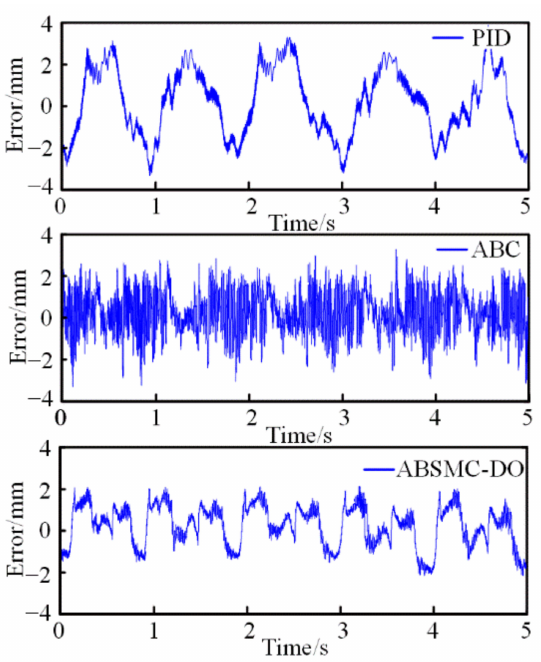
Figure 6. Tracking errors of different controllers with no disturbance. ABC, adaptive backstep- ping controller.